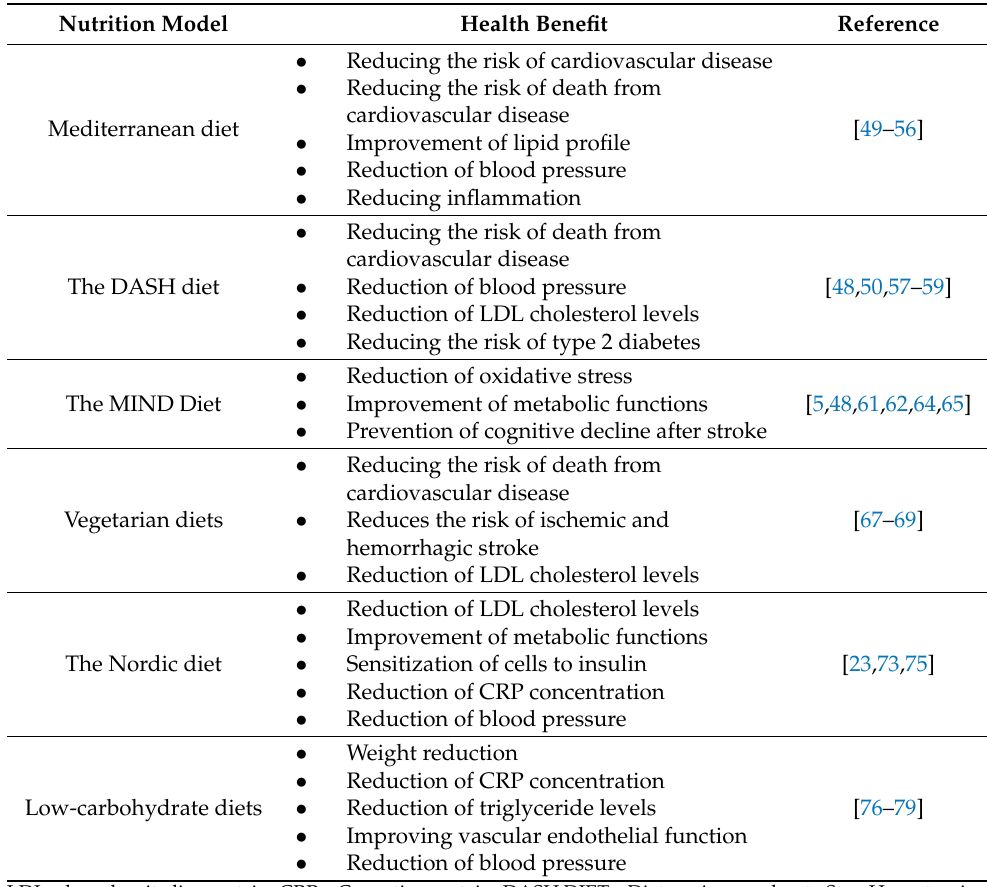
Table 2. Health benefits of selected dietary models in cardiovascular